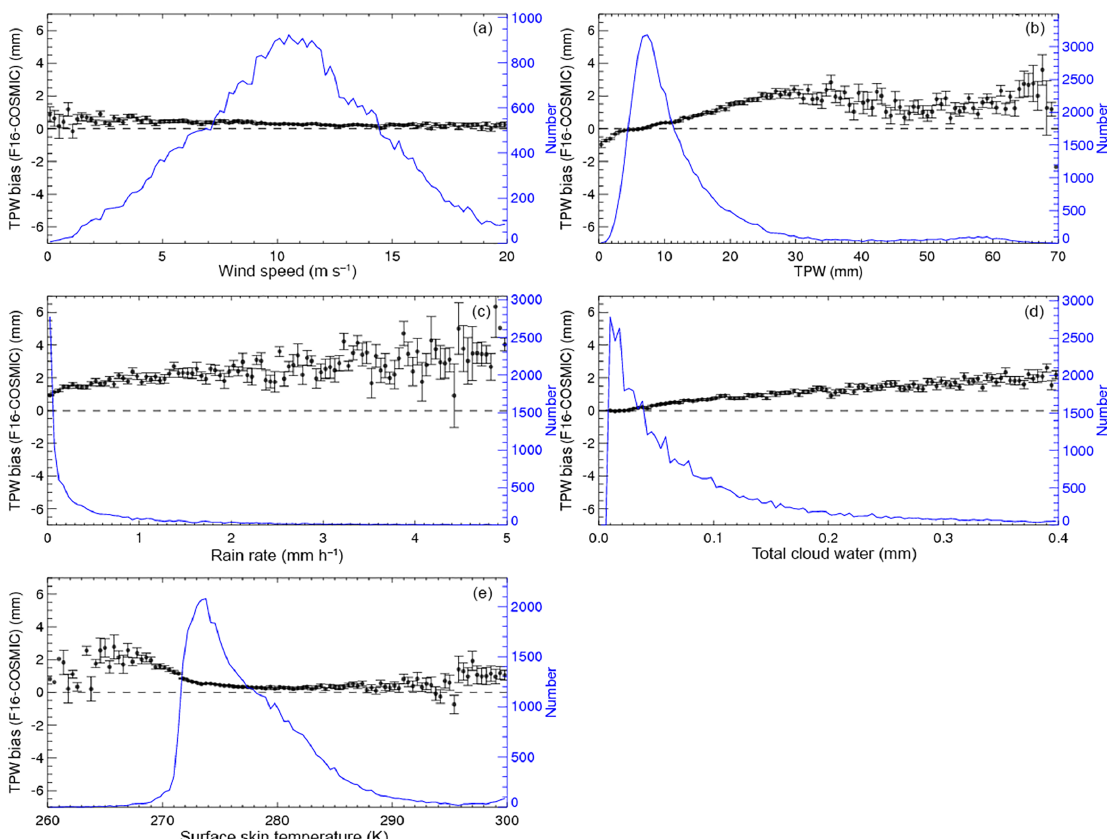
Figure 5. Mean and standard of the mean for the F16–COSMIC TPW biases varying with (a) wind speed (ms − 1 ), (b) TPW (mm), (c) rain rate (mmh − 1 ), (d) total cloud water (mm), and (e) surface skin temperature (K). The vertical black bracket superimposed on the mean denotes the standard error of the mean. The green dashed line is the number of samples, indicated by the scale on the right. Table 3. Mean and standard deviation (SD) of the mean in millimeters of the monthly time series of differences of MW minus RO TPW under various sky conditions. The trend of the RO estimates of TPW (mmdecade − 1 ) and the 95% confidence level are shown below the mean and σ values in each